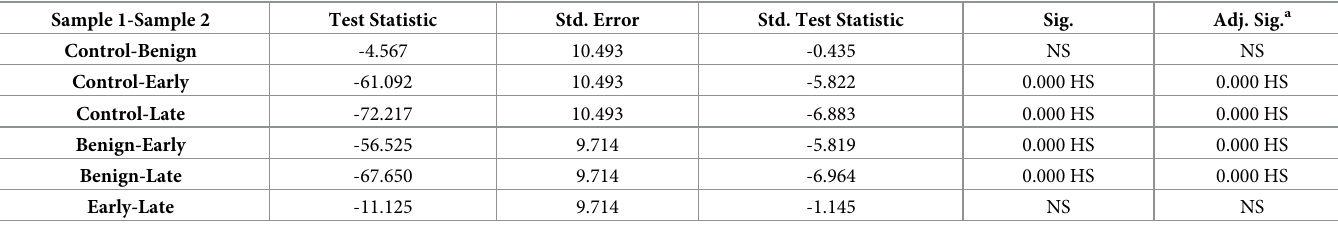
Table 2. Pairwise comparisons of microRNA-204 across all groups.